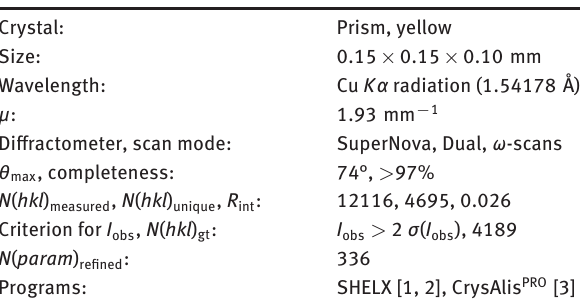
Table 1: Data collection and